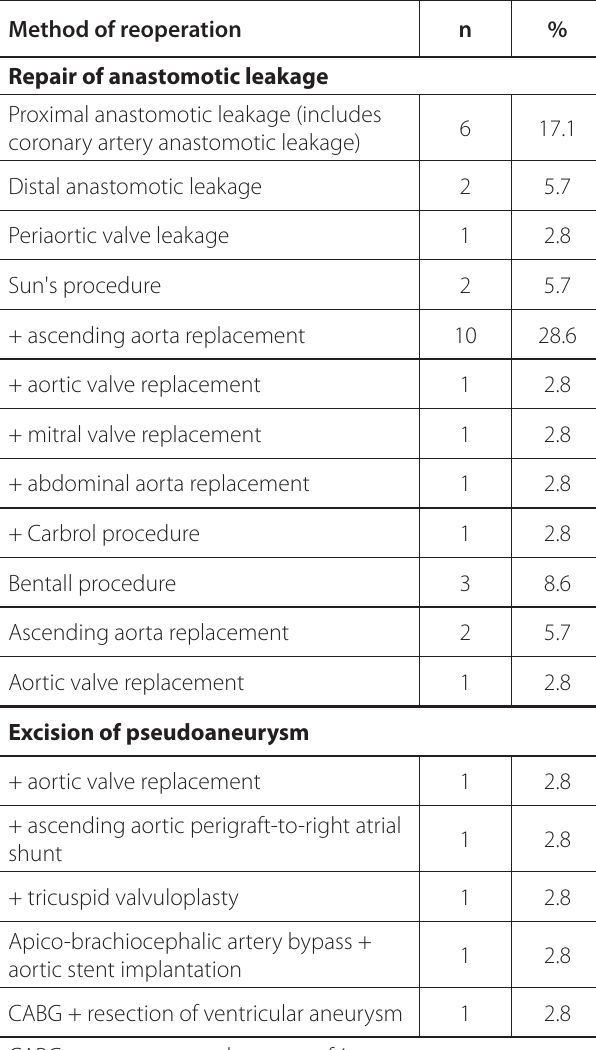
Table 5 . Methods of reoperation. Method of